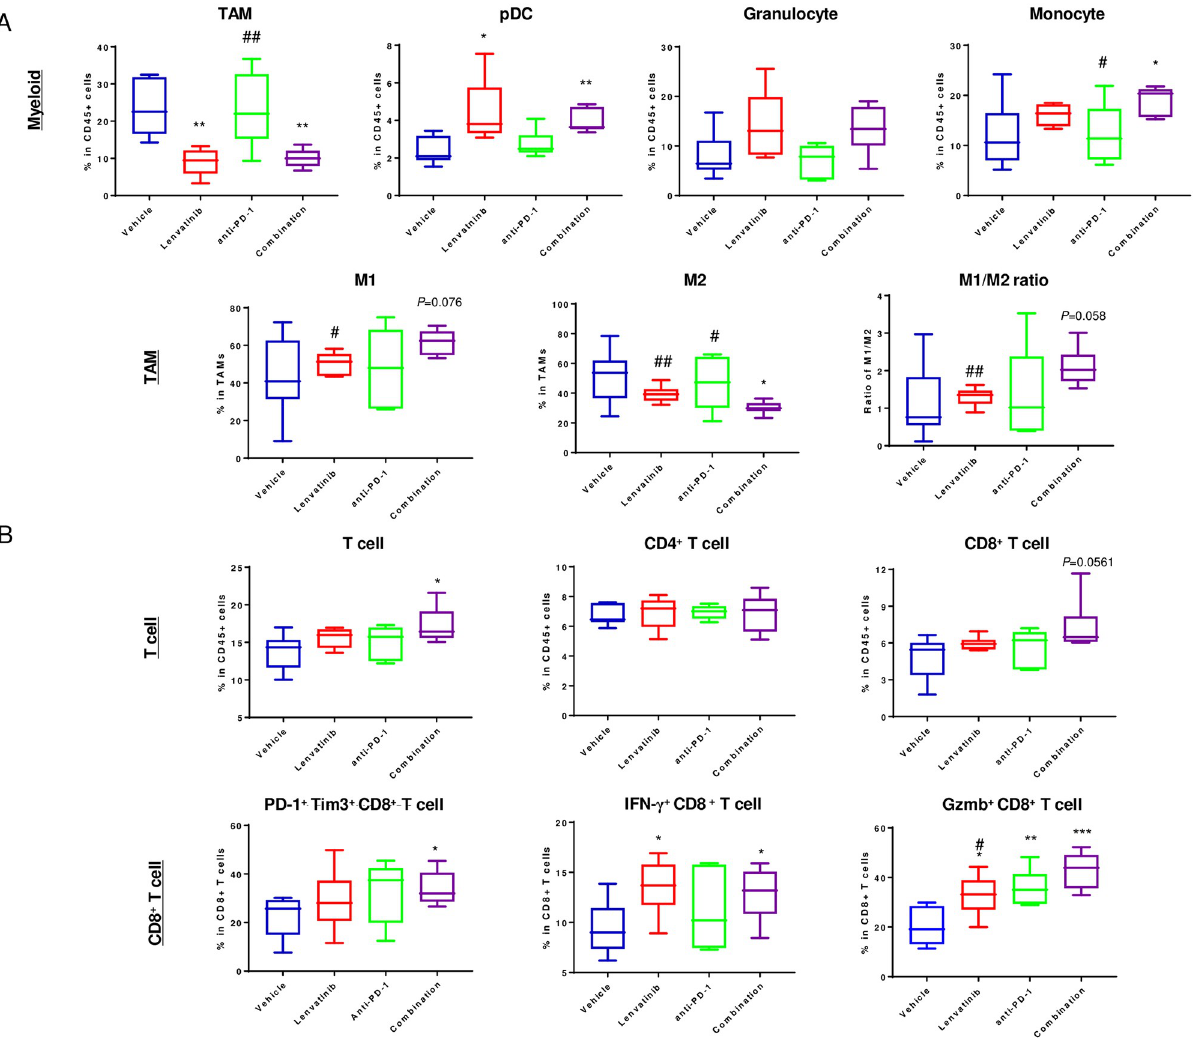
Fig 4. Immune cell population analysis of lymphocytes in the CT26 tumor tissues. A, Percentages of myeloid and TAM cell populations. Upper panel: TAMs, pDCs, granulocytes, and monocytes. Lower panel: M1, M2 in CD45 + cells, and the M1/M2 ratio. B. Upper panel: T cells, CD4 + T cells, and CD8 + T cells. Lower panel: PD-1 + Tim3 + CD8 + T cells, IFN- γ + CD8 + T cells, and GzmB + CD8 + T cells. The gating strategy is shown in S1 Fig. � P < 0.05, �� P < 0.01, ��� P < 0.001, unpaired t-test vs. vehicle; # P < 0.05, unpaired t-test vs. combination (n =